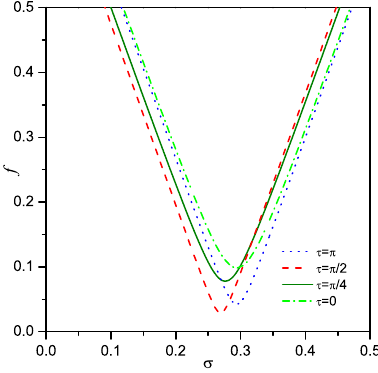
Figure 4. Loci of saddle-node bifurcation points, for p = − 0.05 and different values of τ with velocity feedback. The trajectories of the damped motions of the nonlinear beam are plotted in Figure 5. Points P 1 and P 2 are stable foci, and point P 3 is a saddle point. All initial conditions in the shaded area lead to the steady-state solution on the lower branch P 1 , while all initial conditions in the unshaded area lead to the upper branch P 2 . Thus all the shaded area constitutes the domain of attraction of point P 1 , and all the unshaded area constitutes the domain of attraction of point P 2